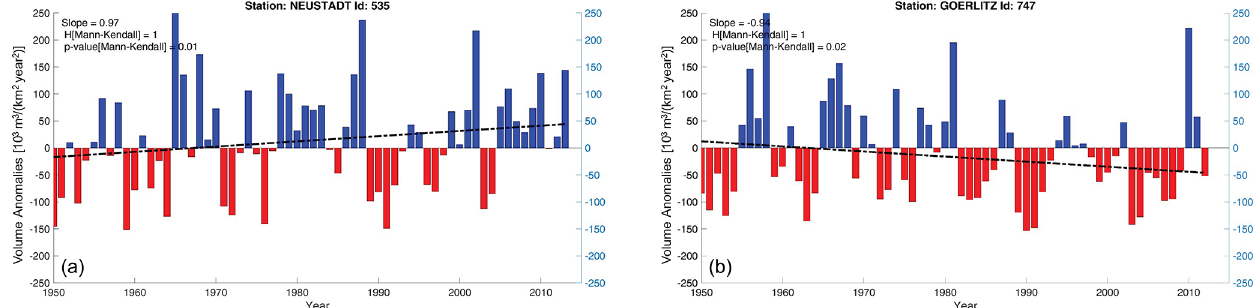
Figure 4. Anomalies in the annual streamflow volumes for the station of Neustadt (a) and Goerlitz (b) . In the graphs, the slope of the Theil–Sen line, H , and p values of the Mann–Kendall test are also reported.